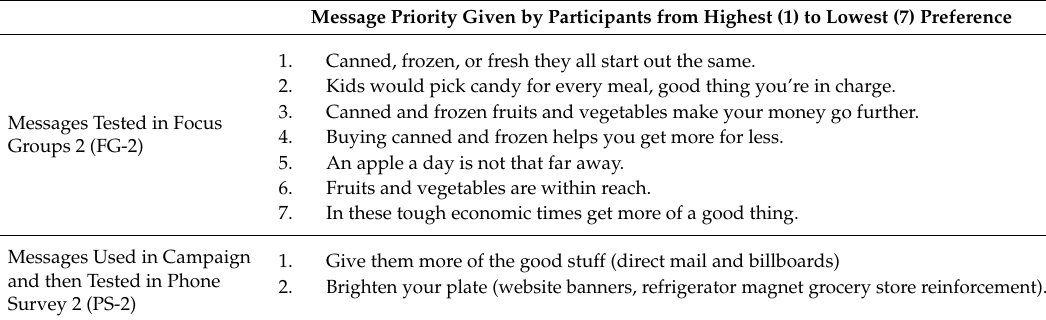
Figure 2. Process for the Design and Testing of Food Hero Logos (Focus Groups 2). Table 1. Food Hero Messages: Tested and Used in Pilot Campaign.